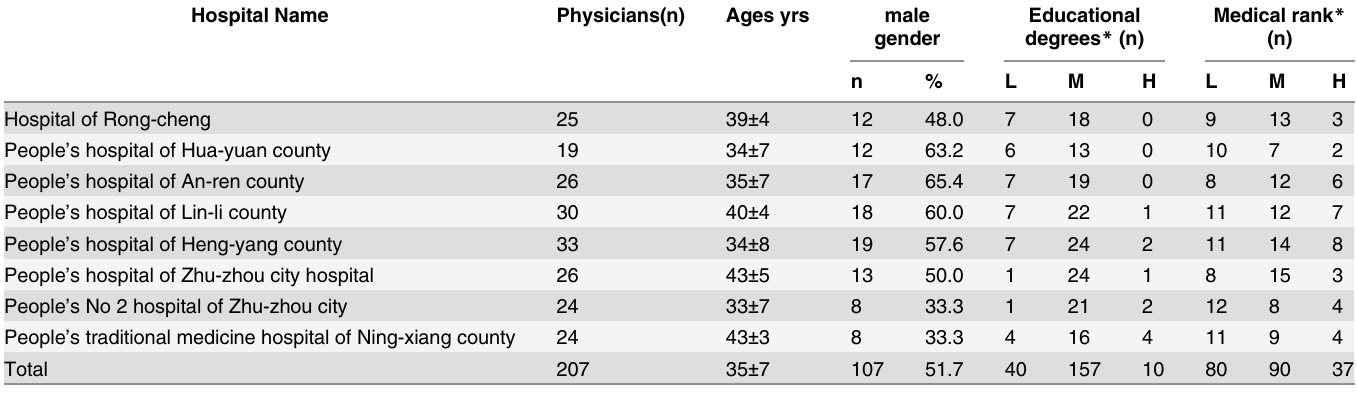
Table 1. Demographics of physicians receiving one-hour training course of COPD. Hospital